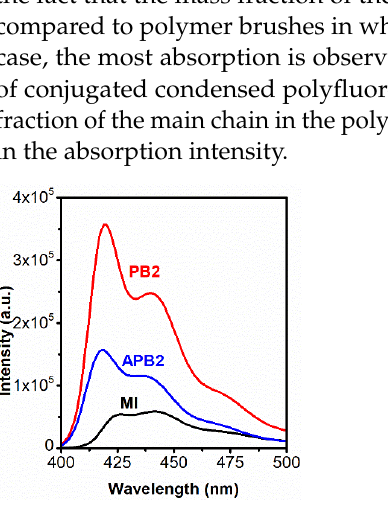
Figure 5. Fluorescence spectra of MI, PB2 and APB2.